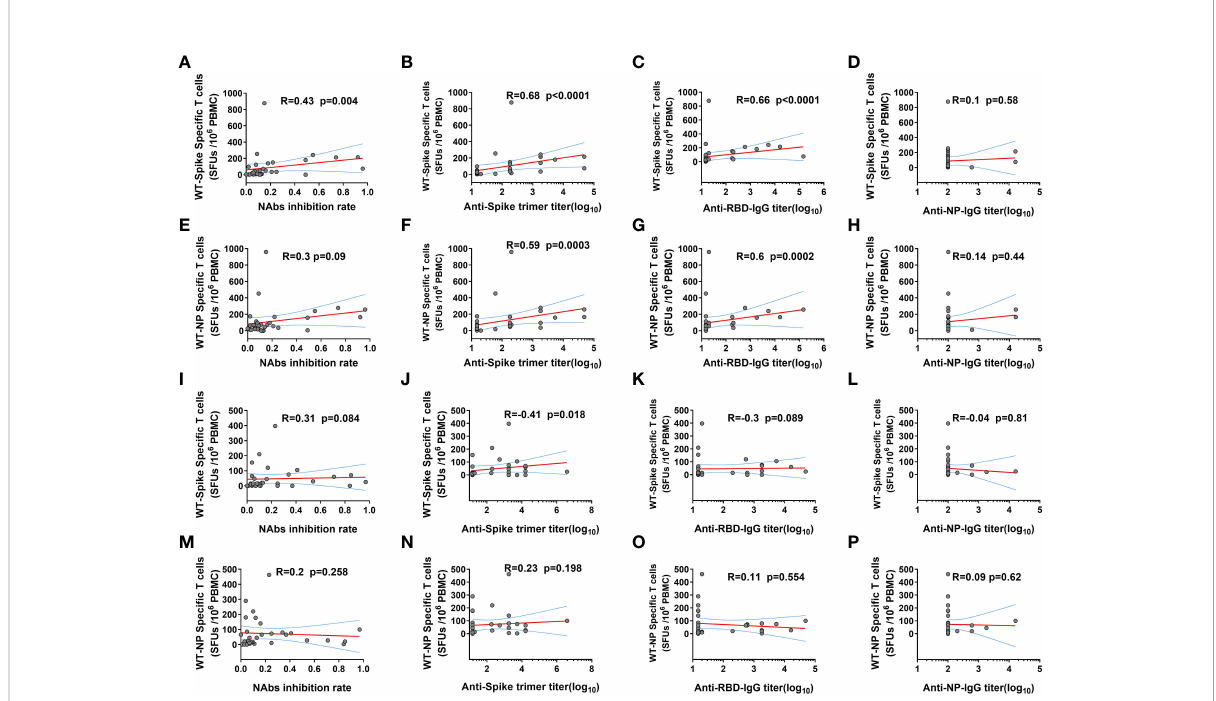
FIGURE 3 The correlation between SARS-CoV-2 ancestral strain speci fi c T cell and humoral immunity response in kidney transplant recipients (KTRs) after homologous inactivated vaccine booster. (A-D) The correlation between SARS-CoV-2 ancestral spike speci fi c T cells frequency and neutralizing antibodies (NAbs) inhibition rate (A) , anti-Spike trimer-IgG (B) , anti-receptor binding domain (RBD) IgG (C) , anti-NP-IgG (D) titers 14 days post booster (DPB). (E-H) The correlation between SARS-CoV-2 ancestral NP speci fi c T cells frequency and NAbs inhibition rate (E) , anti-Spike trimer-IgG (F) , anti-RBD-IgG (G) , anti-NP-IgG (H) titers 14 DPB. The correlation between SARS-CoV-2 ancestral spike speci fi c T cells frequency and NAbs inhibition rate (I) , anti-Spike trimer-IgG (J) , anti-RBD-IgG (K) , anti-NP-IgG (L) titers 28 DPB. (M-P) The correlation between SARS- CoV-2 ancestral NP speci fi c T cells frequency and NAbs inhibition rate (M) , anti-Spike trimer-IgG (N) , anti-RBD-IgG (O) , anti-NP-IgG (P) titers 28 DPB. SFU: Spot forming units. The correlation was determined using Spearman correlation